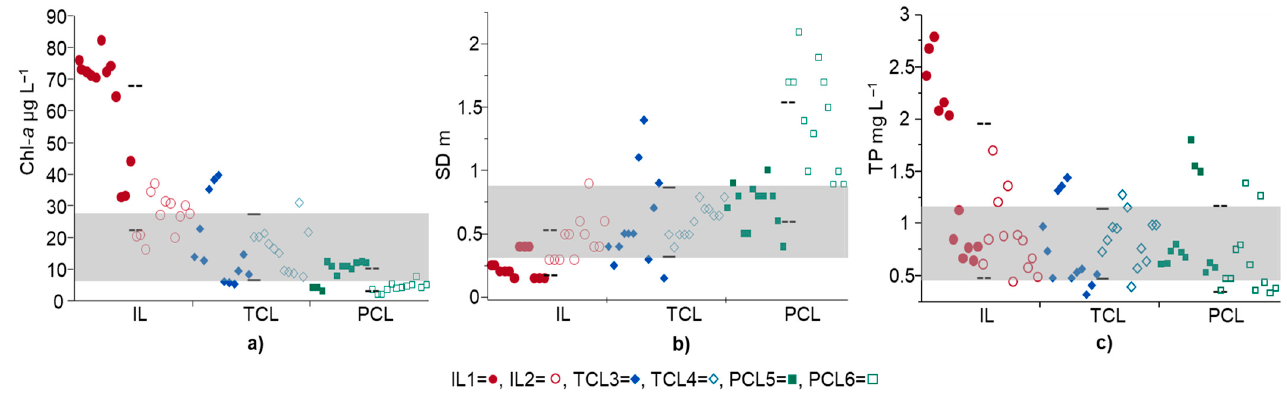
Figure 3. Distribution of the trophic indicator data, Chl- a ( a ), SD ( b ), and TP ( c ), for three condi- tions of surface hydraulic connection. IL = isolated lakes, TCL = temporally connected lakes, PCL = permanently connected lakes. Continuous black lines = TCL average and standard deviation ( 𝑥̅ ± SD). Dotted lines = IL and PCL average and standard deviation ( 𝑥̅ ± SD). Grey area = interval overlap of IL and PCL with TLC. Table 1. Proportionality overlap of indicator data distribution between TCL with IL and PCL and trophic state in three conditions of surface hydraulic connection. mean = 𝑥̅ ; standard deviation = SD.